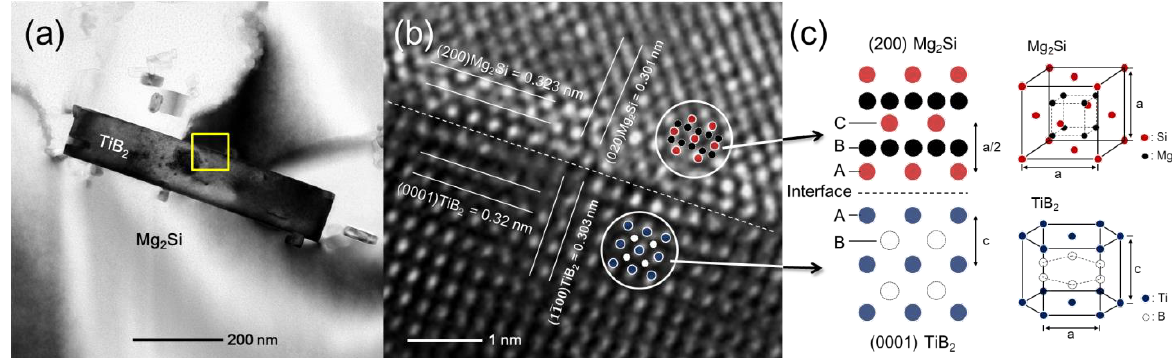
Figure 6. TEM micrographs of the modified eutectic Al + Mg 2 Si phases in the Al–8Zn–6Si–4Mg–2Cu–1Ti alloys: ( a ) the bright field TEM image of the modified eutectic Al + Mg 2 Si phases with TiB 2 particles; ( b ) is the corresponding high- resolution TEM image of the yellow box in ( a ); and ( c ) the illustration of stacking order of (200) Mg₂Si plane and (0001) TiB₂ plane.